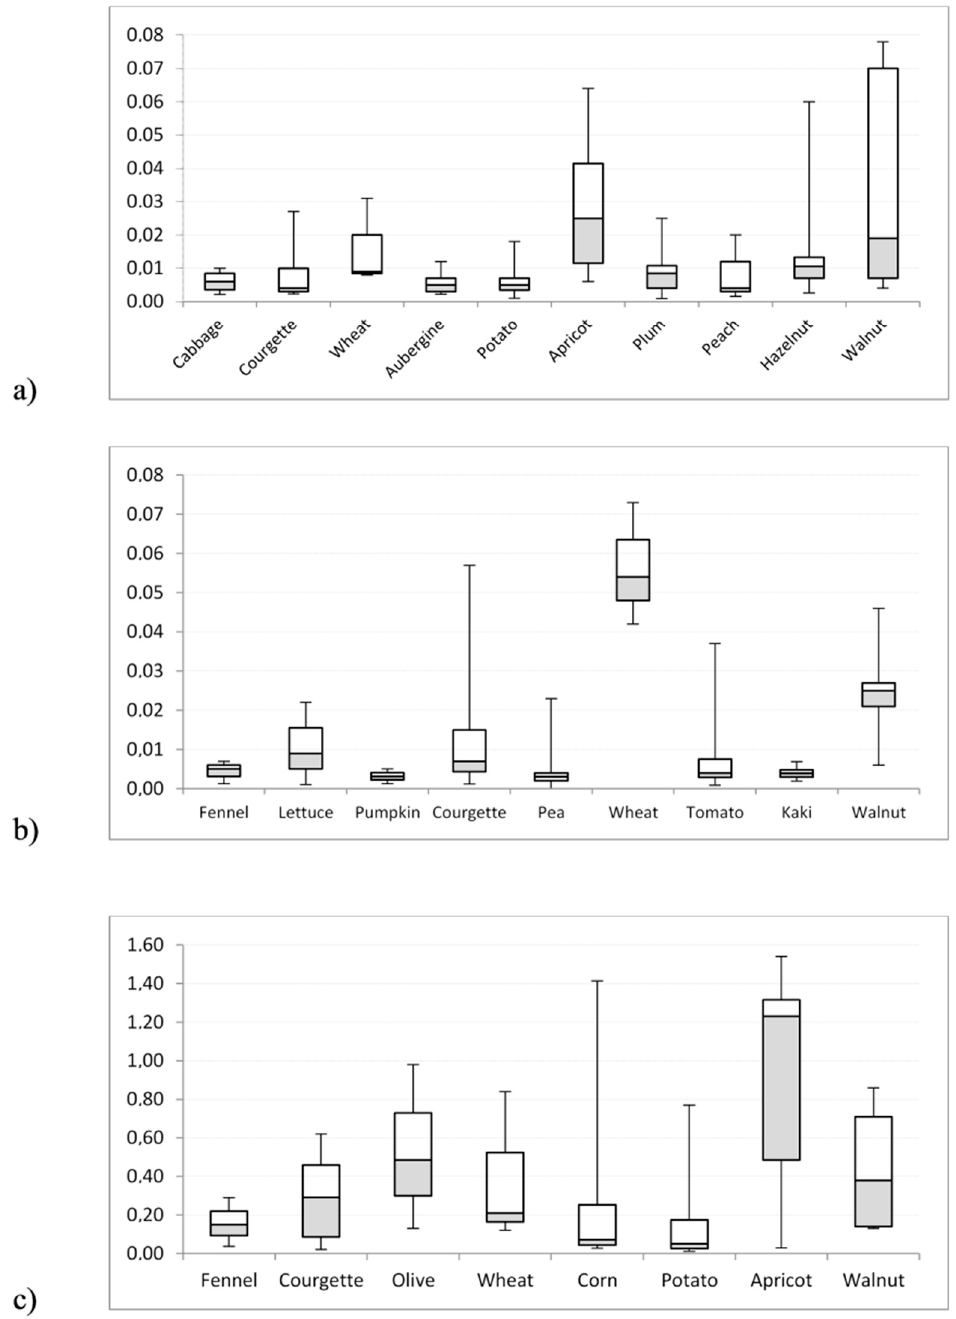
Figure 2. Box–whisker plots of median concentrations of PCDD/Fs ( a ), DL-PCBs ( b ), and NDL-PCBs ( c ) in vegetable samples collected in the “Land of Fires” (Campania, Italy). Values are expressed as pg TEQ/g for PCDD/Fs and DL-PCBs, and as ng/g for NDL-PCBs.